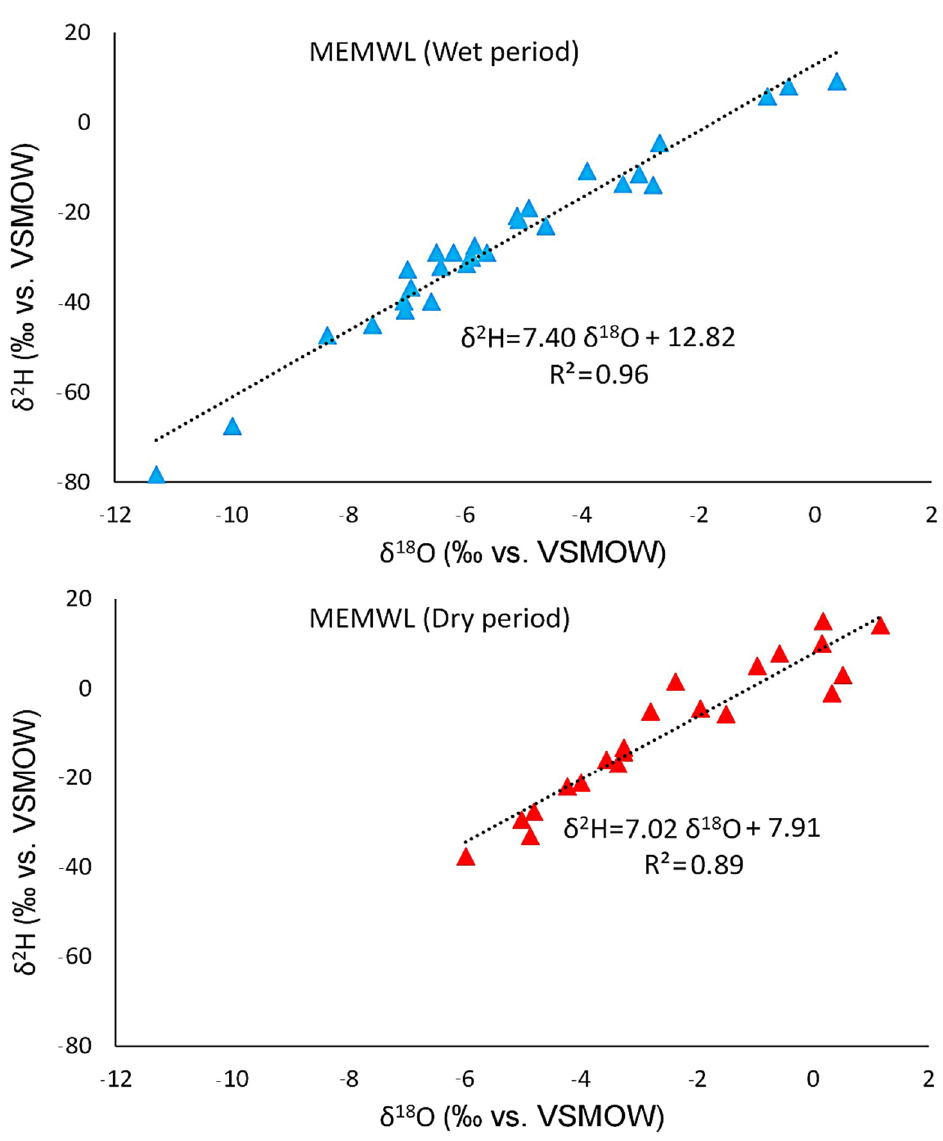
Figure 7. Developing the meteoritic water lines for the Middle East (MEMWL) in the hot and dry as well as the cold and wet periods.